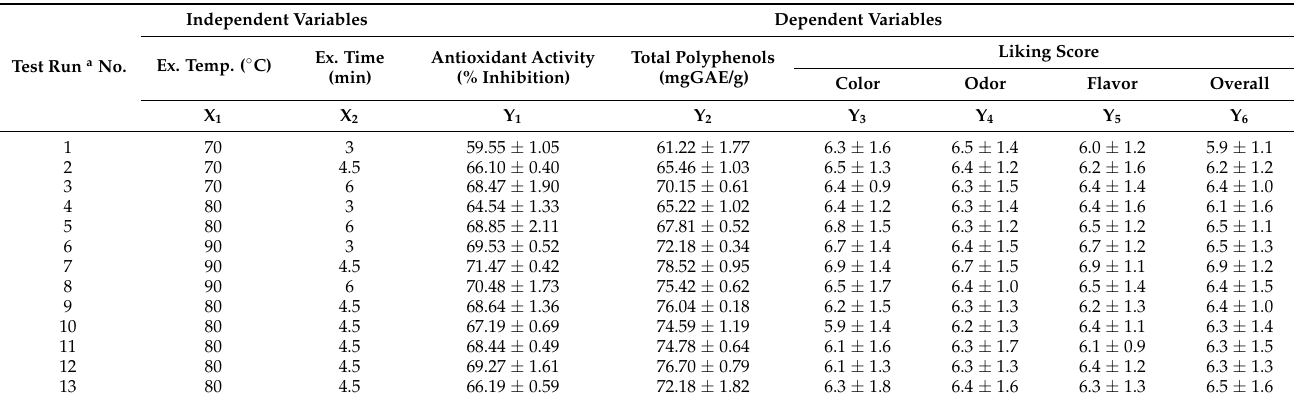
Table 4. Factorial design arrangement and response of the dependent variables to extraction process conditions (independent